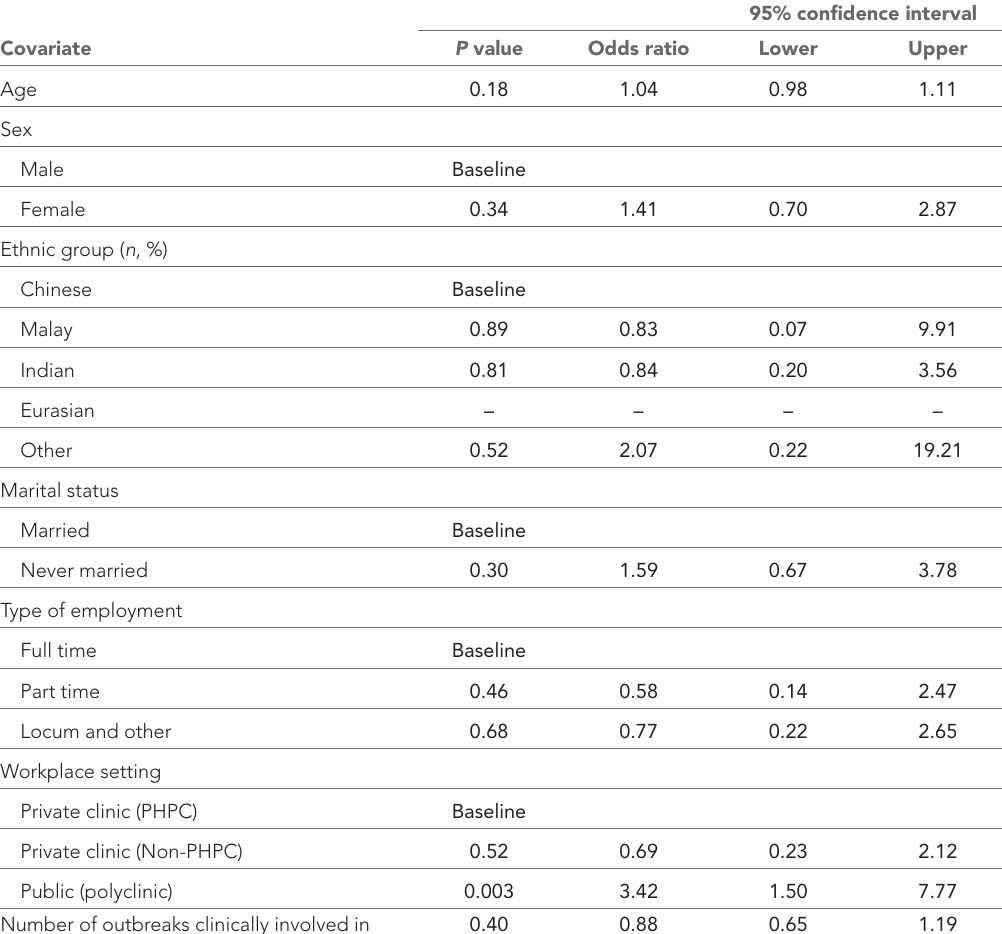
Table 2 Sociodemographic and work environment correlates of anxiety